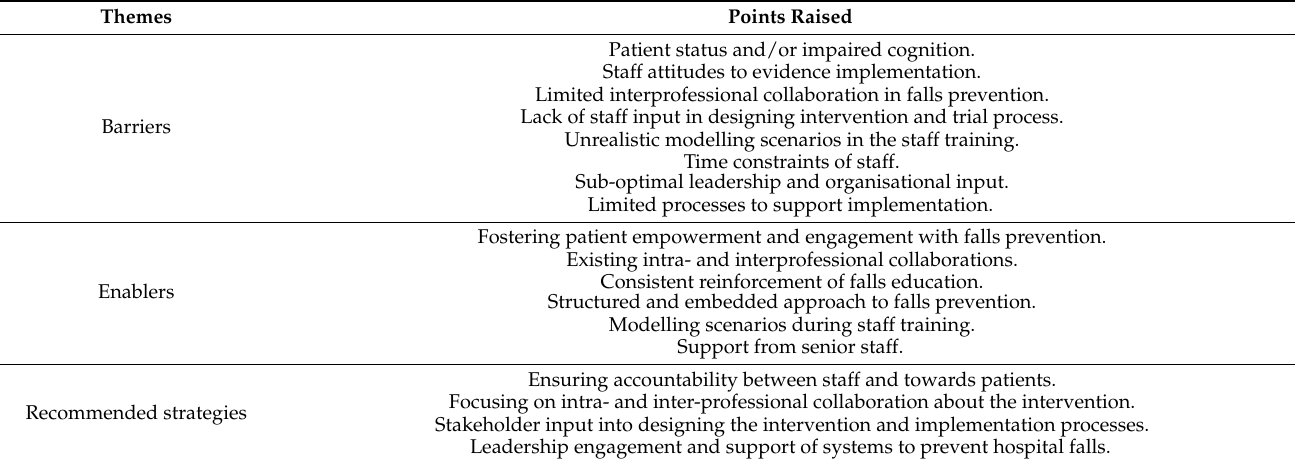
Table 2. Summary of